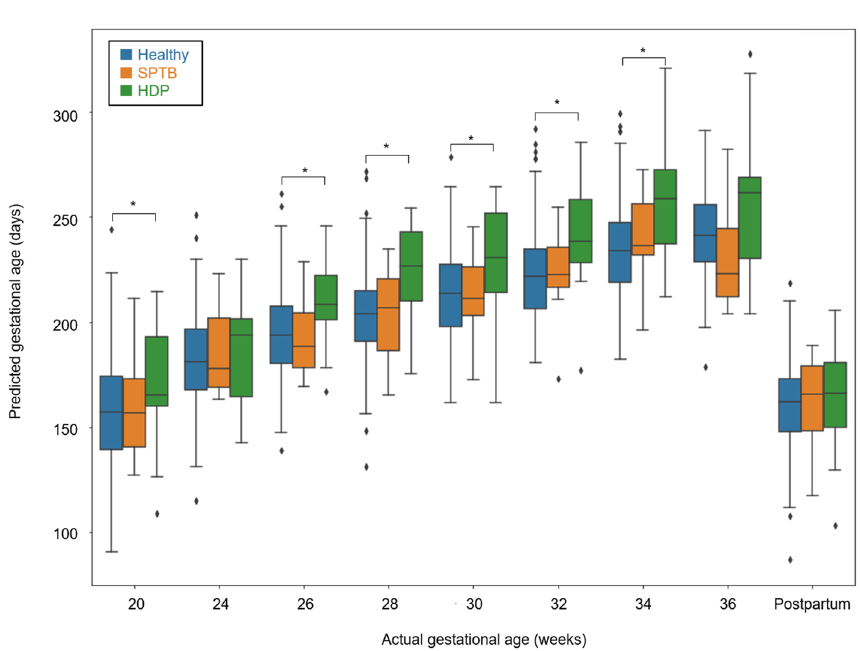
Figure 4. Comparison of predicted gestational ages among healthy, SPTB, and HDP cases. Asterisks indicate statistically significant differences by Welch’s t-test ( p < 0.05) between healthy cases and those with pregnancy